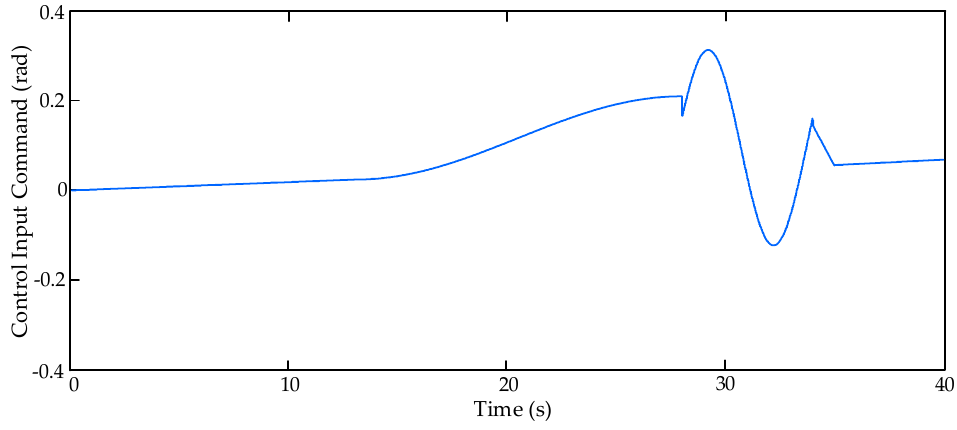
Figure 9. Flight control input command of the hybrid actuation system (HAS).